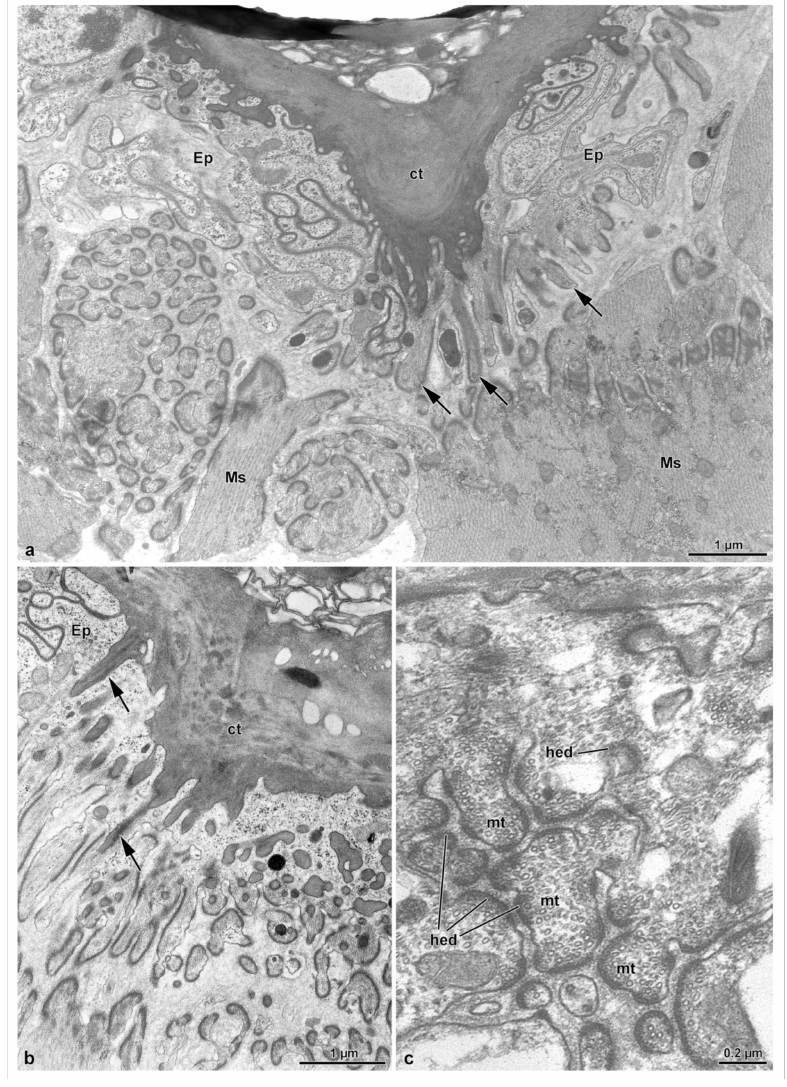
Figure 3. ( a – c ). Cross sections of the spermathecal duct. The thick cuticle (ct) lining the thin epithelium (Ep) shows long tubular prolongments (arrows) directed towards the thin cytoplasm. Around these structures, numerous longitudinal microtubules (mt) are visible reaching the basal lamina to form hemidesmosomes (hed). Beneath the epithelial cells, a thick layer of muscle cells (Ms) is